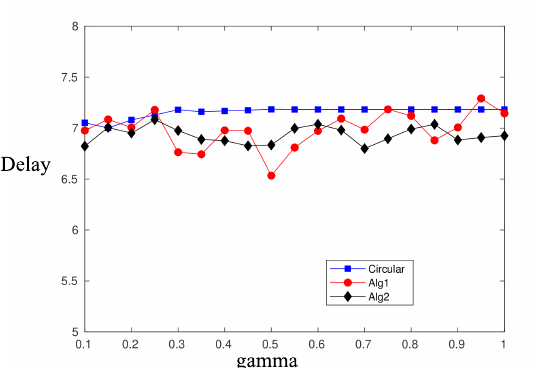
Figure 11. Delay—Compare sector selection strategies for β = 0.